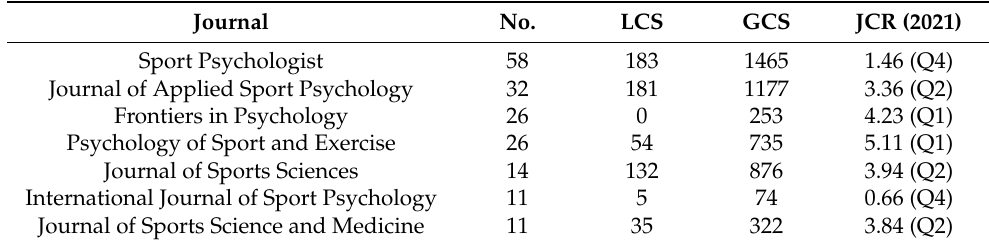
Table 4. Journals by the Number of Publications and Citation Received (LCS and GCS) and Impact Factor